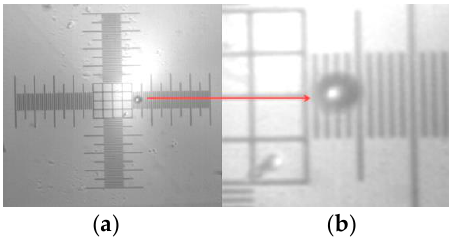
Figure 6. Microbubble image taken with a MSC-20-30 micropipette, microbubble over the 1 DIV/10 µ m micrometric ruler and ( b ) zoomed version of the microbubble